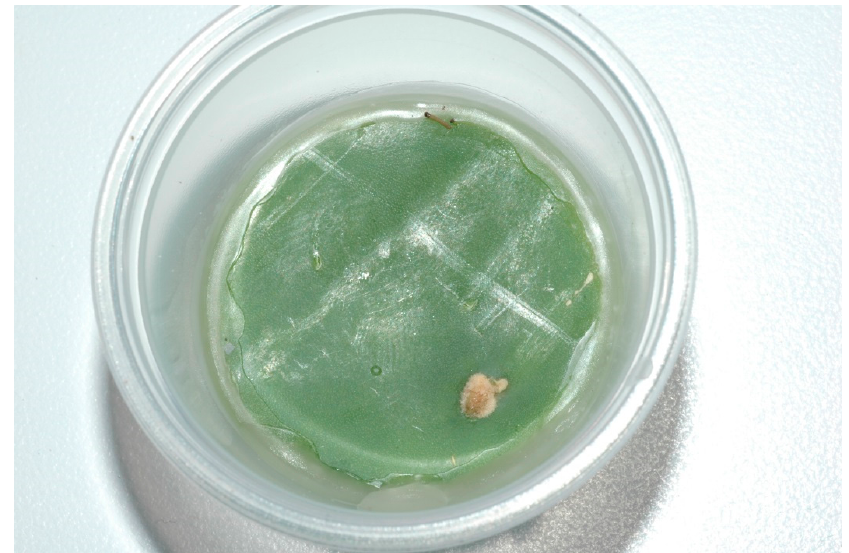
Figure 2. Container with section of cladode and single caterpillar. Top removed for clarity.